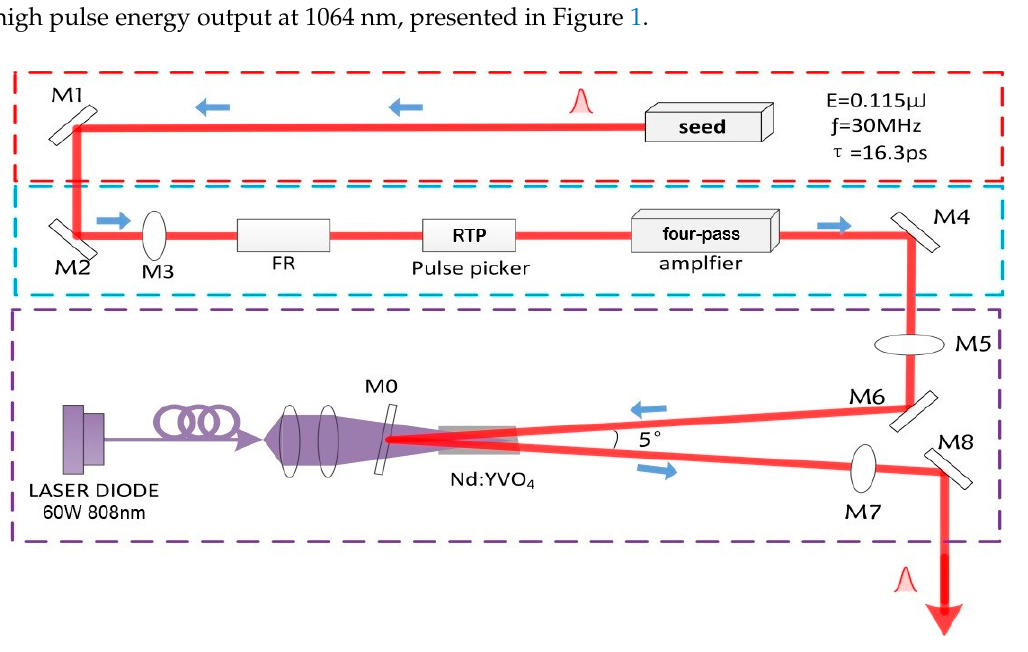
Figure 1. Schematic diagram of the 500-kHz level high energy double-pass Nd:YVO 4 picosecond amplifier experimental setup. amplifier experimental